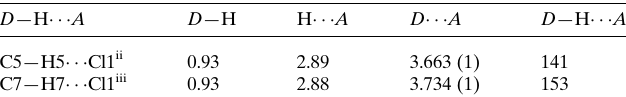
Table 2 Hydrogen-bond geometry (A˚ , (cid:3) ).